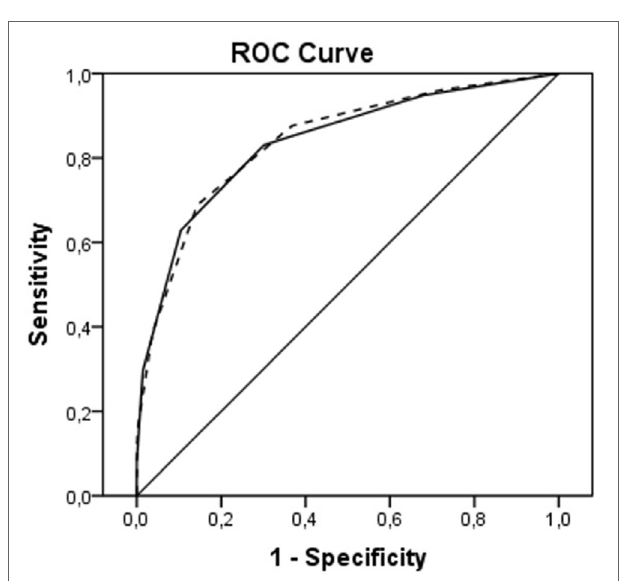
FigUre 2 | Receiver operating characteristic (ROC) curves for intracerebral hemorrhage (ICH) score (solid line) and New ICH score (dashed line).